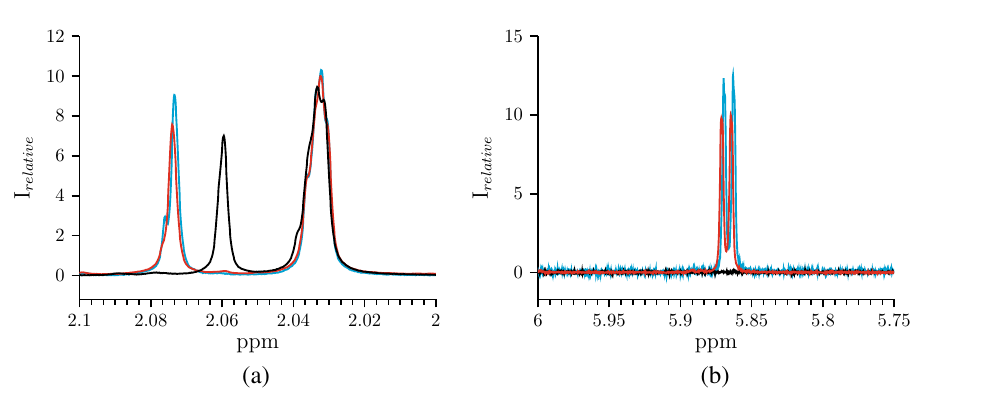
Figure 6. 1 H-NMR spectra of the reaction mixtures containing HA after treatment by: S. hyalurolyticus lyase, HPC homogenate, leech head homogenate. ( a )—The signal of protons of N-acetyl-D- glucosamine acetyl group of HA chains, (b)—The 1 H signal of protons at double bond in (cid:31) 4,5 -unsaturated glucuronic acid